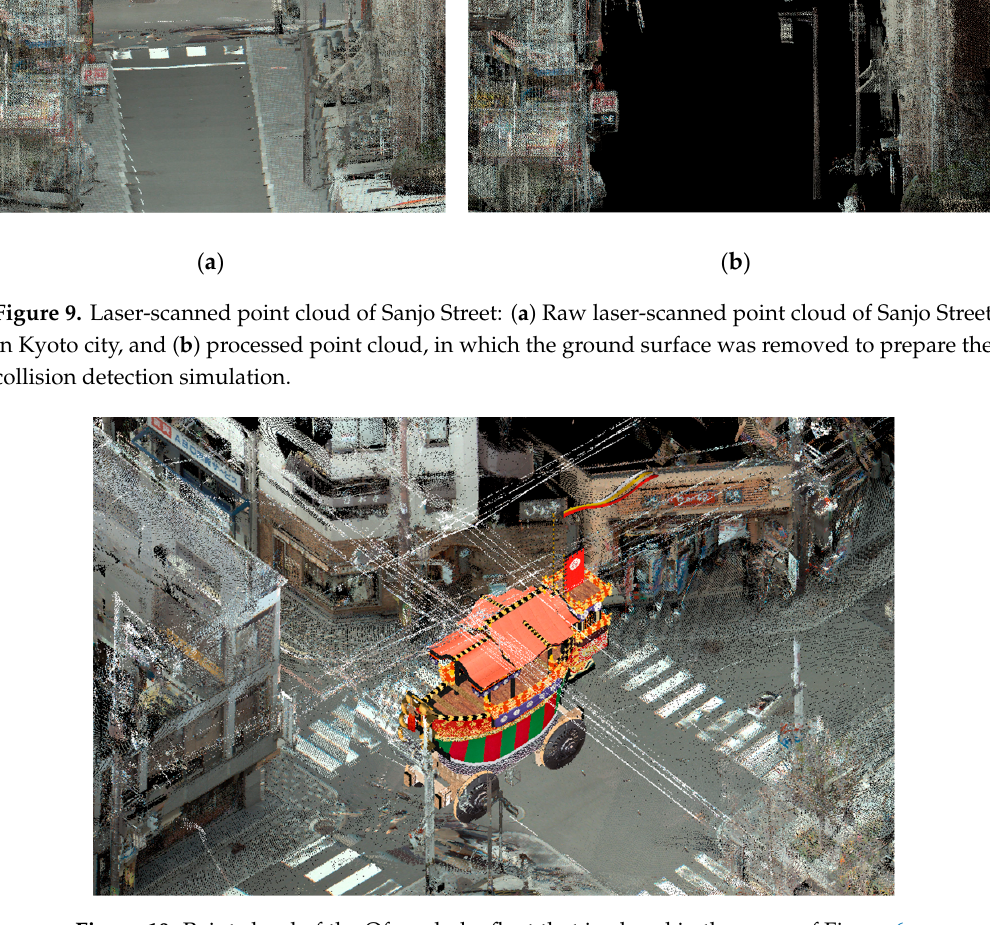
Figure 11. Transparent visualization of the Ofune-hoko when it collides with electric wires. The total number of points that is used for the visualization is 1.02 × 10 7 . The ground surface data are removed to avoid the intersection of the float with the ground surface.